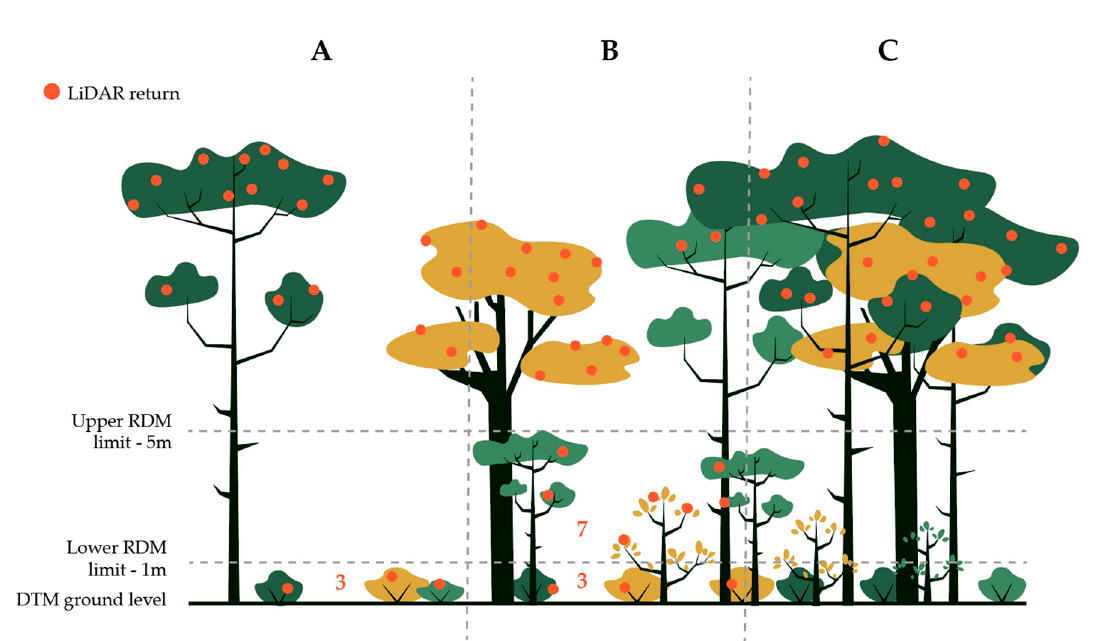
Figure 5. Illustration of relative density model (RDM) calculation method (Number of returns between the upper and lower RDM limits/Number of returns between the ground level and the upper RDM limits). (A) The RDM is equal to 0/(0+3) = 0, indicating that the undergrowth has been crushed or removed. (B) The RDM is equal to 7/(7+3) = 0.7, indicating intact undergrowth with little or no disturbance of vegetation in the 1 – 5 m range of heights. (C) The RDM is equal to 0/(0+0) = undefined, indicating the forest is very dense, with an intact canopy not disturbed.